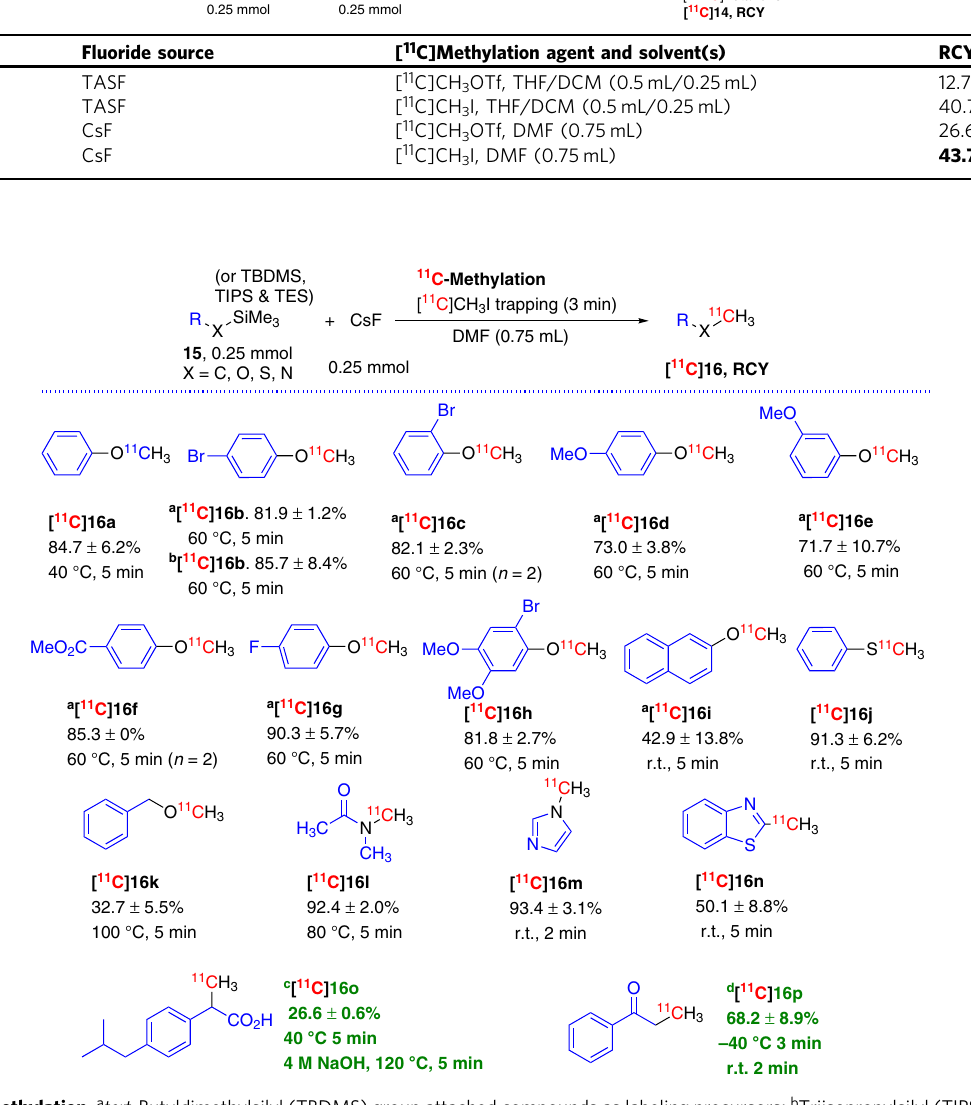
Fig. 5 FMDS 11 C-methylation. a tert -Butyldimethylsilyl (TBDMS) group attached compounds as labeling precursors; b Triisopropylsilyl (TIPS) group attached compound as labeling precursor. c Triethylsilyl (TES) group attached ethyl ester as labeling precursor; [ 11 C]CH 3 I was collected at r.t., 3 min, then 40 °C, 2 min; Next saponi fi cation: 4 M NaOH, 120 °C, 5 min; products were puri fi ed by semi-prep HPLC. d TASF was used as fl uoride source, THF (0.5 mL)/DCM (0.25 mL) was used as solvent, [ 11 C]CH 3 I was collected at − 40 °C, 3 min, reaction mixture was left at r.t., 2 min, products were puri fi ed by semi-prep HPLC; starting radioactivity of [ 11 C]CH 3 I: 7.3 ± 2.67 GBq; total synthesis time: 37.7 ± 1.2 min; radiochemical purity (RCP) > 99% and A m : 29.7 ± 10.9 GBq/ µ mol (end of bombardment,